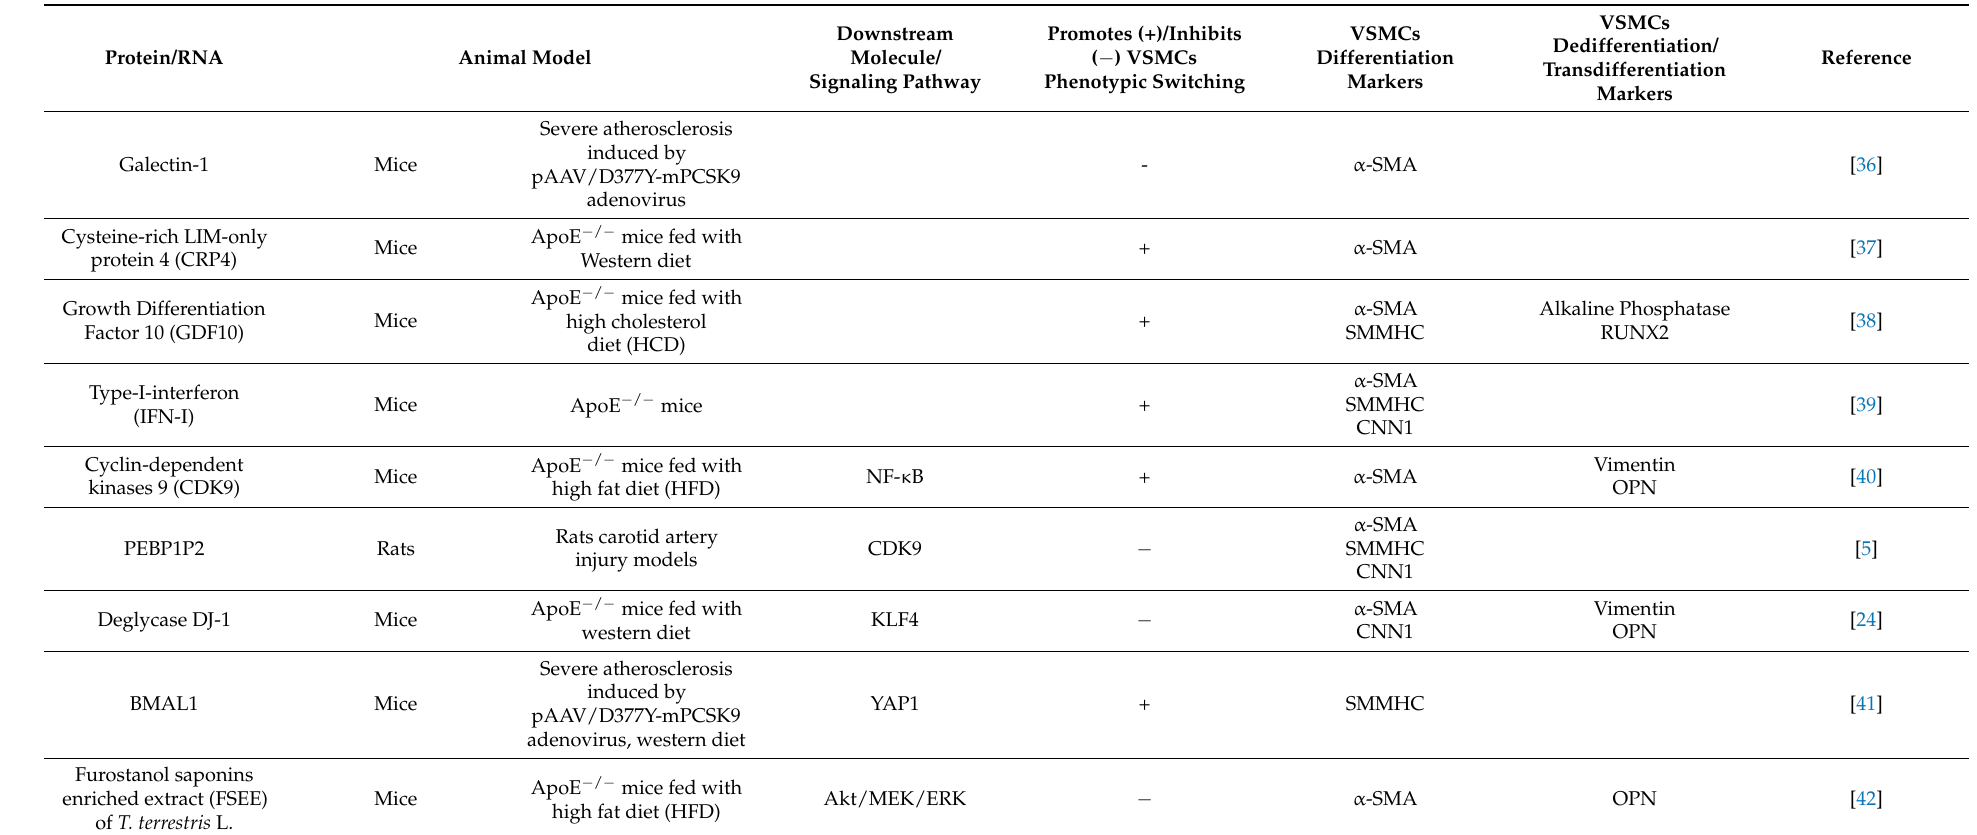
Table 1. Molecular mechanisms of VSMCs phenotypic switching in